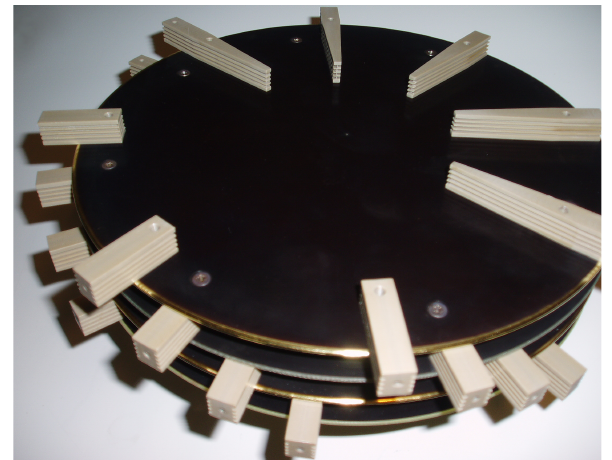
Fig. 6. Plot showing the simulated percentage of protons of differ- ent energies that reach a representative detector at nominal deflector HV settings of